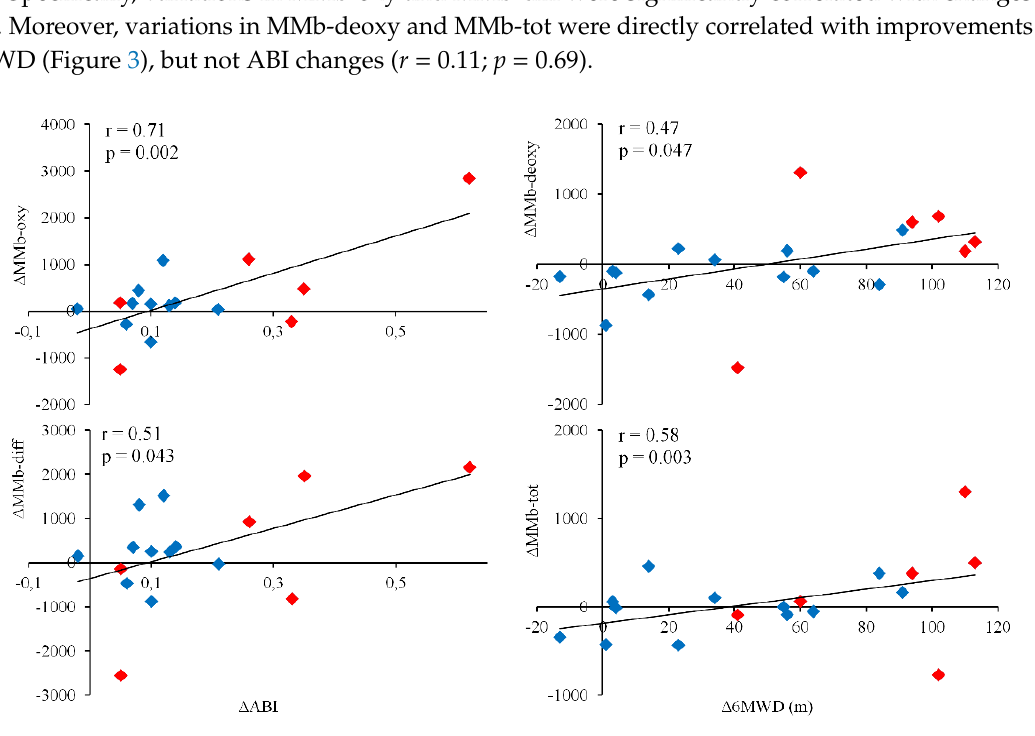
Figure 3. Rank correlation between variations of MMbs and variations of hemodynamic and functional parameters after interventions. Red: Rev group; Blue: Ex group; ABI: ankle–brachial index; 6MWD: 6-minute walking distance.